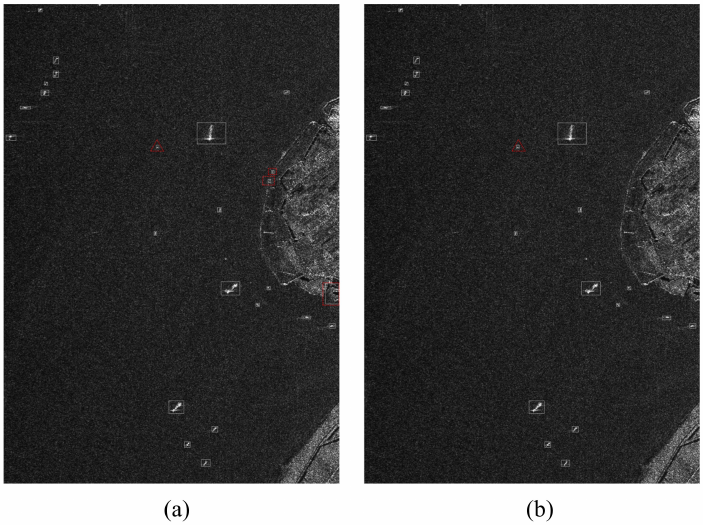
Figure 16. Detection results of the proposed algorithm. ( a ) Rough detection results; ( b ) Precise detection